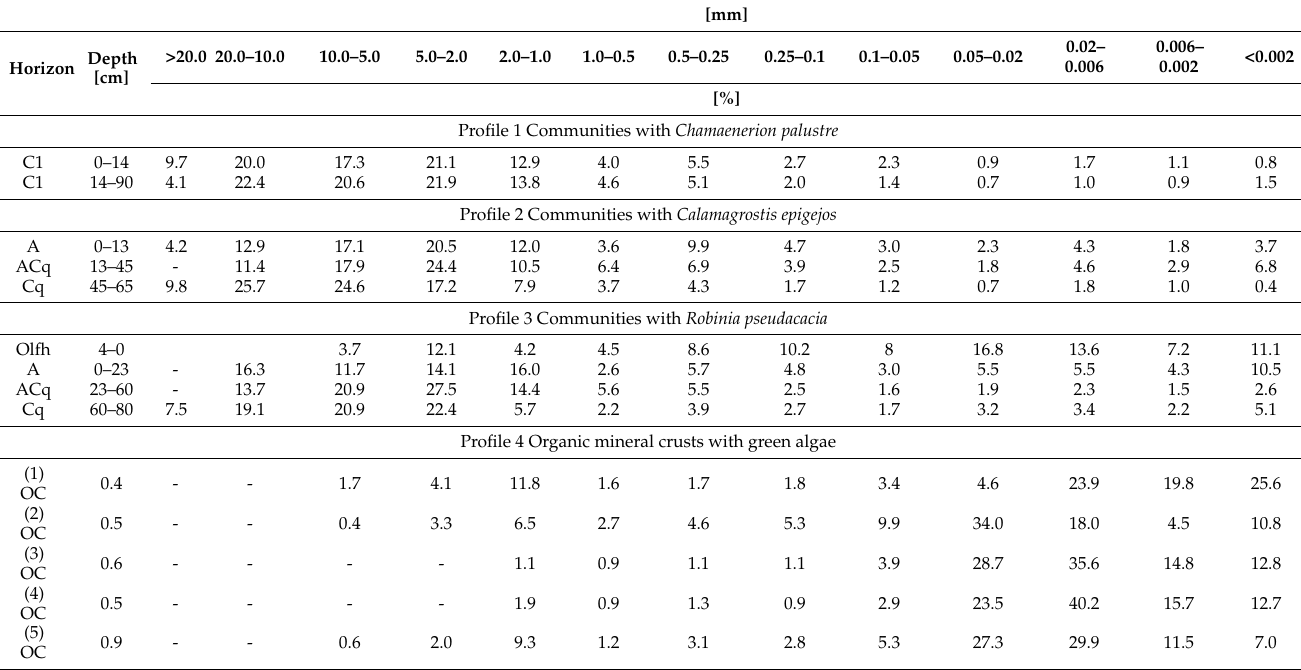
Table 1. Percentage share of granulometric composition in coal dump.